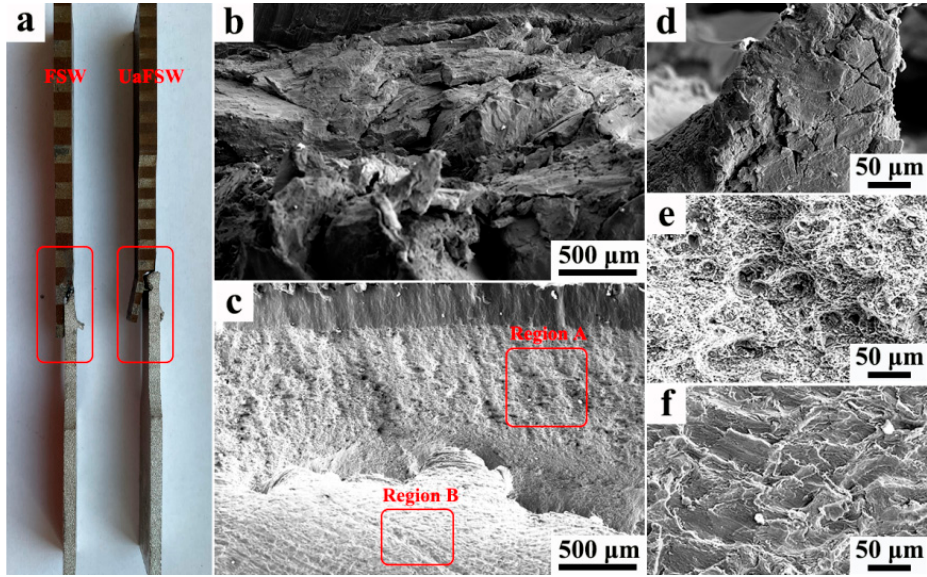
Figure 10. ( a ) The image of failure tensile specimens, the fracture surface of ( b , d ) FSW joint, and ( c ) UaFSW joint; the magnified SEM images of ( e ) region A and ( f ) region B in the UaFSW